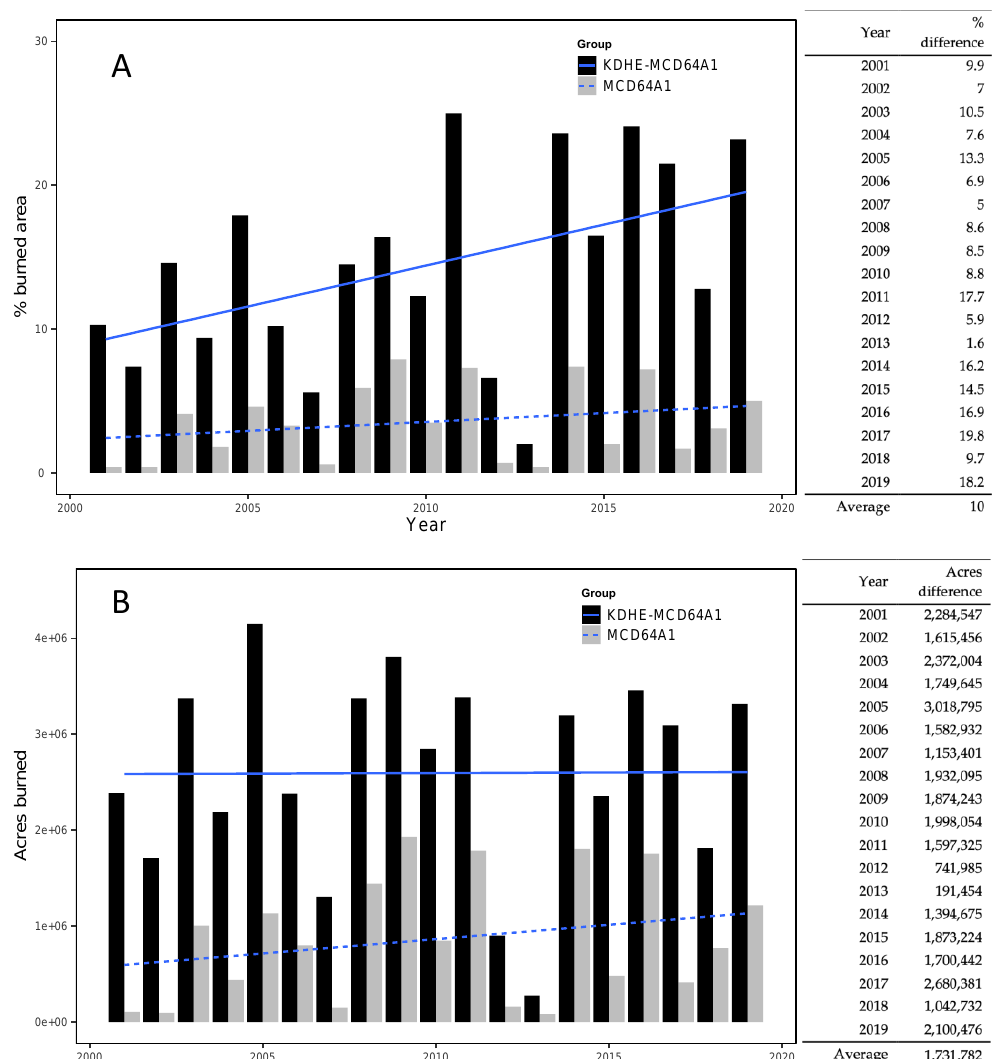
Figure 2. Annual trends in percent burned area ( A ) and acres burned ( B ) between the MCD64A1 and KDHE-MCD64A1 customization. The corresponding tables to the right of the Figure represents the annual differences between the percent and acreage products.